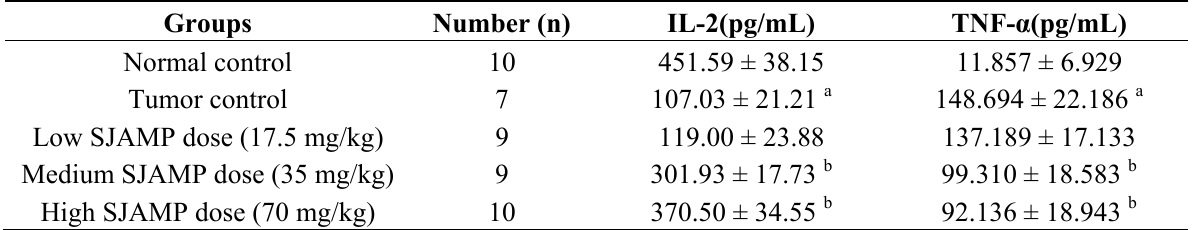
Table 9. Effect of SJAMP on serum cytokines production in rats with DEN-induced HCC ( x ±